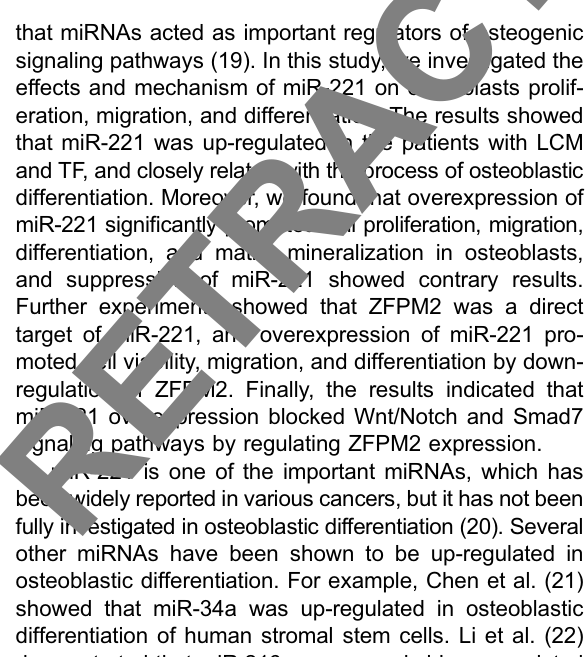
Figure 5. ZFPM2 was a direct target of miR-221. A , The binding site of miR-221 and ZFPM2 was analyzed by TargetScan and microRNA database. B , mRNA and protein levels of ZFPM2 were examined by qRT-PCR and western blot. C , The relationship between miR-221 and ZFPM2 was detected by dual-luciferase reporter assay. ZFPM2: zinc fi nger protein multitype 2; miR-221: microRNA-221; qRT-PCR: quantitative reverse transcription polymerase chain reaction. Data are reported as means ± SD. *P o 0.05